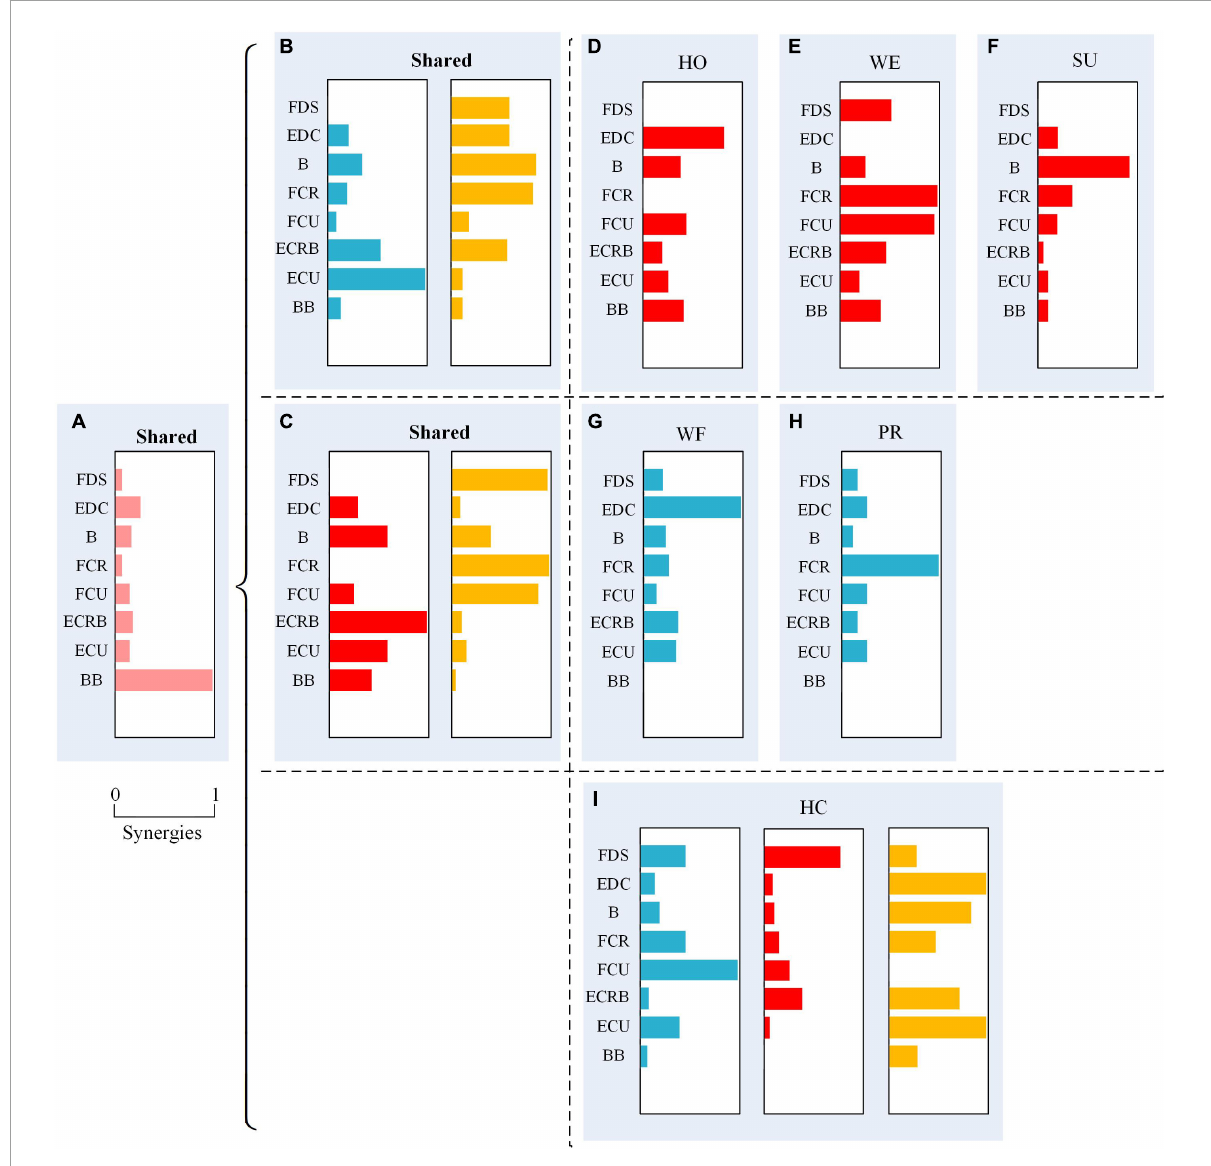
FIGURE5 A mixture of synergies shared across different movements and synergies for specific movements showing six movements have a shared synergetic module (A) ; hand open (HO), wrist extension (WE), and supination (SU) have two shared synergetic modules (B) ; wrist flexion (WF) and pronation (PR) have two shared synergetic modules (C) ; and the special synergetic modules (D–I) of six